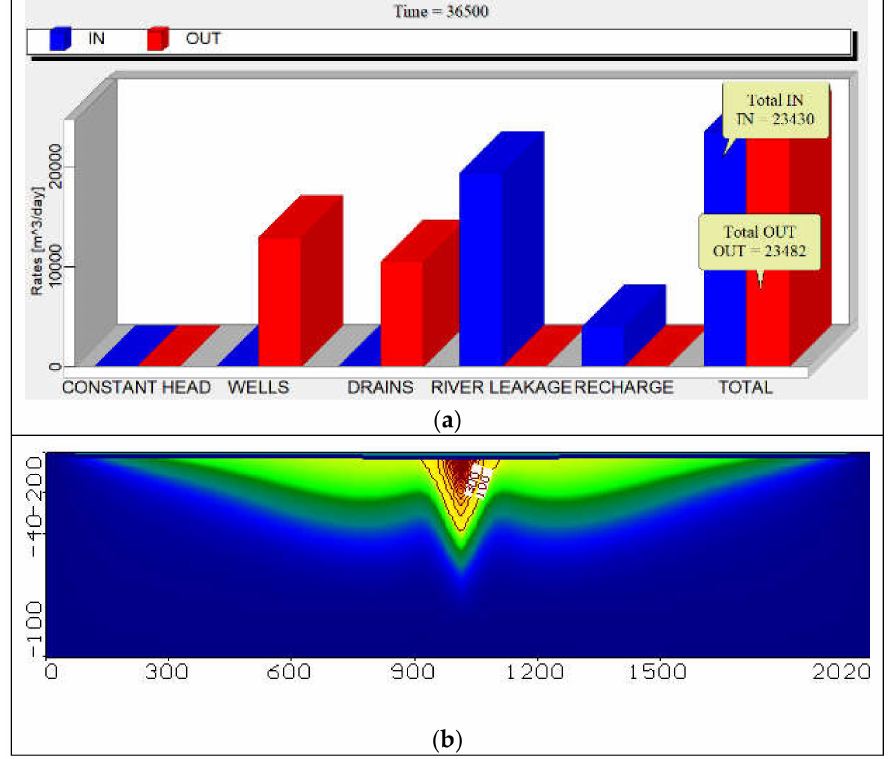
Figure 4. Zone budget and aerial view concentration of COD in the study area (Base case).